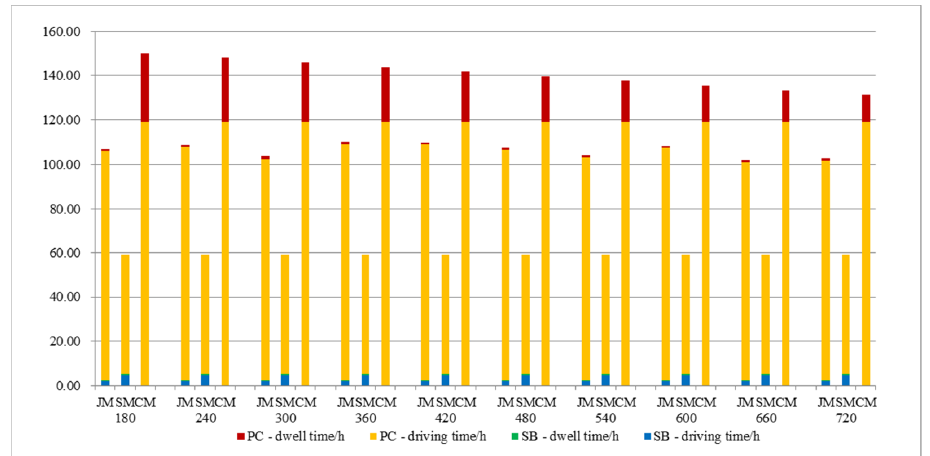
Figure 10. Various cost variations with parameter Δ t .